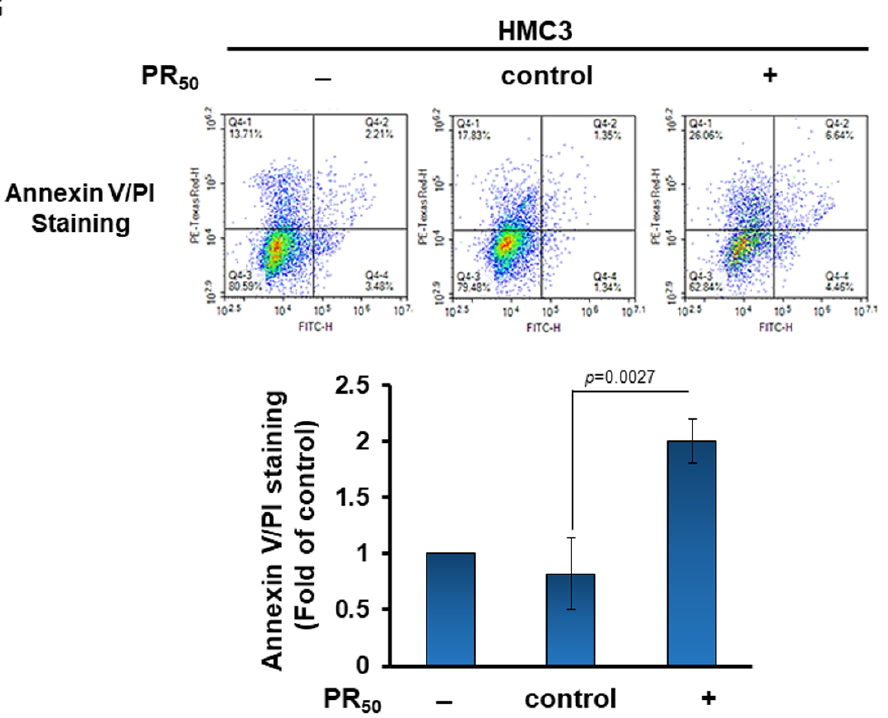
Figure 1. Intracellular expression of PR 50 induces priming and activation of the NLRP3 inflam- masome in human HMC3 microglial cells. HMC3 cells were transfected with a control vector or PR 50 plasmid for 24 h. ( A ) Immunofluorescence staining of PR 50 (green) using myc-tag antibody. DAPI was used for nuclear staining. PR 50 mainly aggregated into spots in the nucleus ( white arrows ) . ( B ) Immunofluorescence staining of NF- κ Bp65 (red) and Myc-tag (green). Expression of PR 50 promotes the movement of NF- κ B p65 from the cytoplasm to the nucleus ( white arrows ) . DAPI was used for nuclear staining. ( C ) Extract of cell nucleus was analyzed for the level of NF- κ B p65 by Western blot- ting. TBP was used as a loading control. The bottom panel is a quantitative analysis graph using ImageJ software. ( D ) NF- κ B p65 transcription factor activity assay showed that expression of PR 50 promotes NF- κ B activity. TBP was used as a loading control for input. This study was performed in triplicate (n = 3). ( E ) Cell lysates were analyzed for the expression of PR 50 (Myc), NLRP3, ASC, pro caspase-1, cleaved caspase-1 (p20), pro IL-1 β , cleaved IL-1 β (p17), pro IL-18, and cleaved IL-18 by Western blot- ting. GAPDH was used as a loading control. The left panel shows a representative set of images, and the right panel shows quantitative analysis graphs using ImageJ software. ( F ) The level of mature IL- 1 β and mature IL-18 in the conditional medium of all groups were measured by ELISA. ( G ) Apoptotic cell ratio was determined by annexin v-FITC and propidium iodide (PI) staining via flow cytometry (upper panel). Q2 is a late apoptotic cell, Q4 is an early apoptotic cell, Q3 is a live cell, and Q1 is a dead cell. Apoptosis ratio = (Q2 + Q4)/ (Q1 + Q2 + Q3 + Q4) × 100% (lower panel).